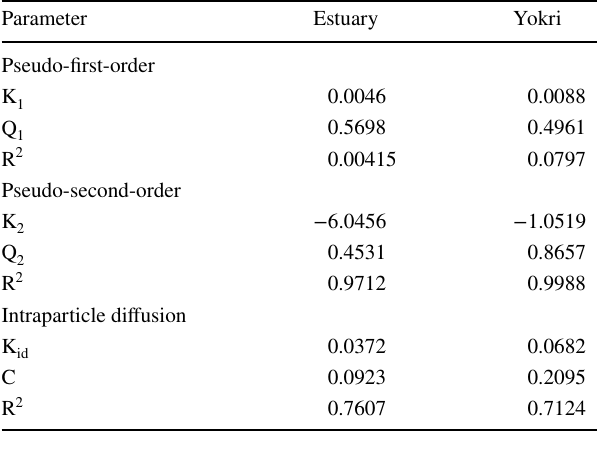
Table 3 Kinetic Model Parameters on Sorption of Crude oils unto FBPC